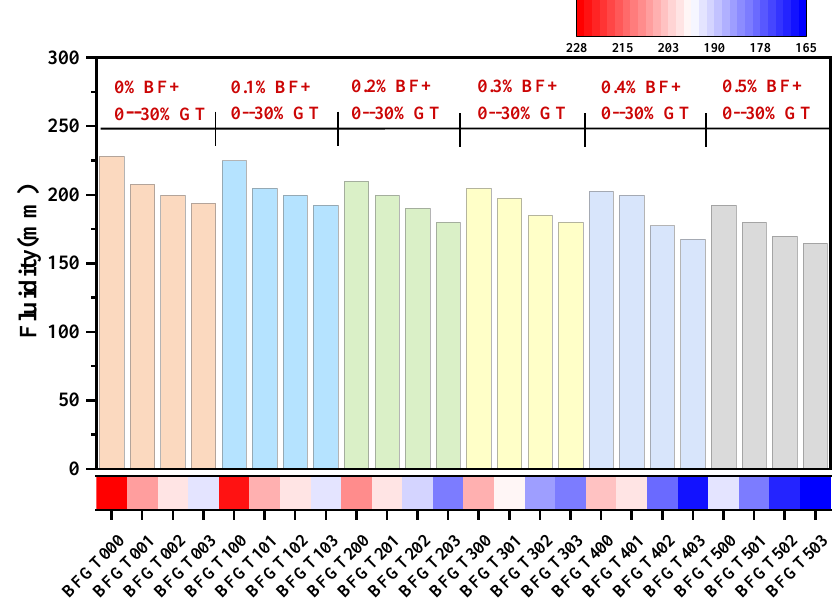
Figure 4. Effect of basalt fibres on workability of graphite tailings cement mortar.